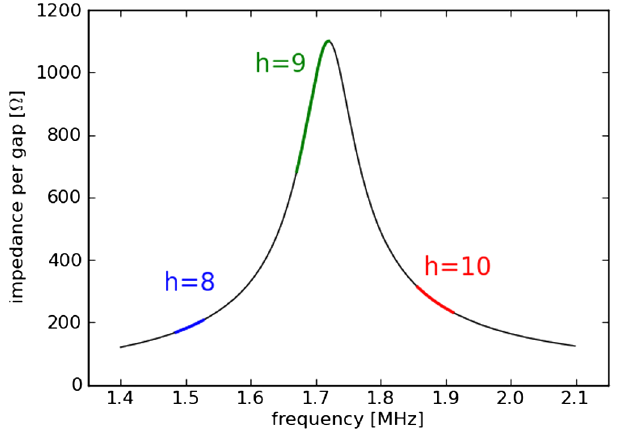
FIG. 1. The frequency response of the accelerating gap and the harmonics covered by the